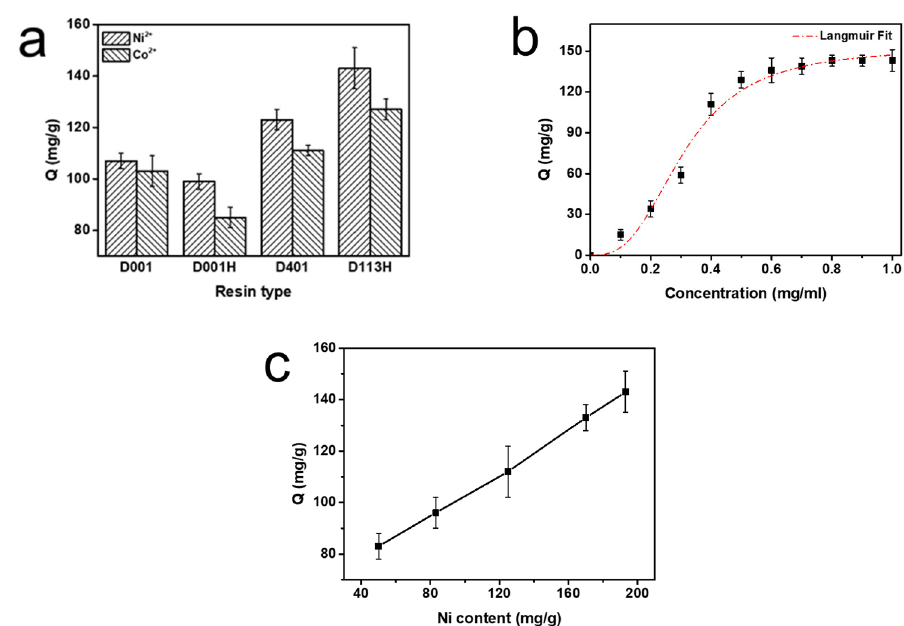
Figure 2. ( a ) Enzyme immobilization capacity (Q, mg/g) of PMI with different resin types, ( b ) en- zyme immobilization capacity (mg/g) of PMI on Ni-chelated ion exchange resin at different PMI concentrations, and ( c ) enzyme immobilization capacity (mg/g) of PMI on Ni-chelated ion exchange resin with different Ni-chelating amounts.